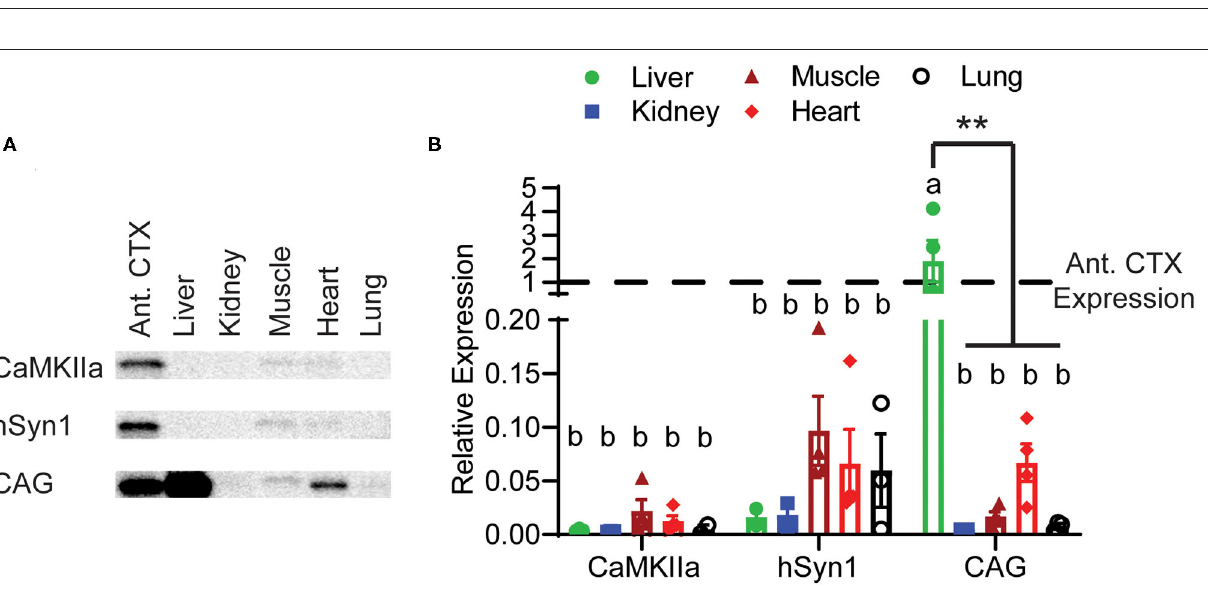
FIGURE 5 | Peripheral expression of GFP limited by neuron-specific promoters. (A) Representative images of Western blotting. (B) Expression of GFP in peripheral tissues relative to expression in the anterior cortex. Both the hSyn1 and CaMKII α promoters drove significantly less GFP expression in the liver than the CAG promoter. Dashed line indicates level of expression in anterior cortex. Data points represent values for each mouse; mean ± SEM ( n = 4) are indicated. **denotes p < 0.05 by two-way ANOVA and Tukey’s post-hoc test. Bars annotated with the same lower-case letter are not statistically significant from each